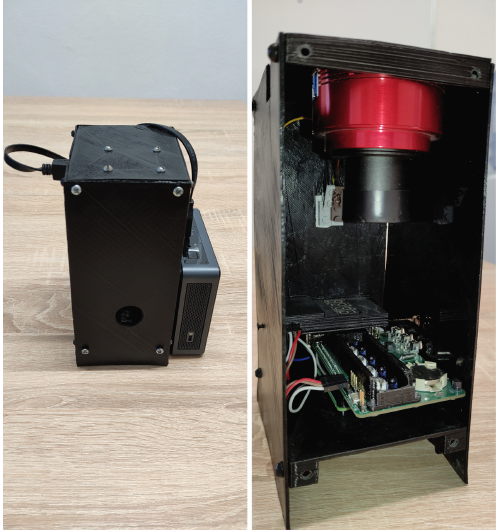
Figure 1. The designed acquisition unit in the ready-to-use version ( left ) and its interior after removing the front panel ( right ). On the back panel, there is an LED illuminating the upper surface of the finger (on the figure this element is partially covered by the